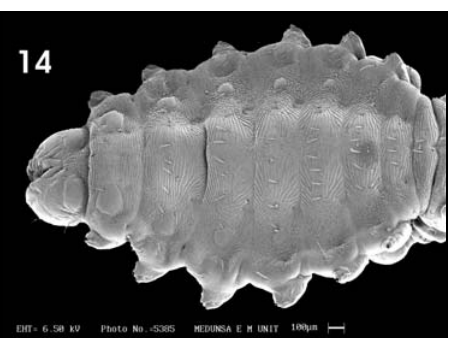
Fig. 16. The flap-like claspers (C) of the female were lined with setae (S).